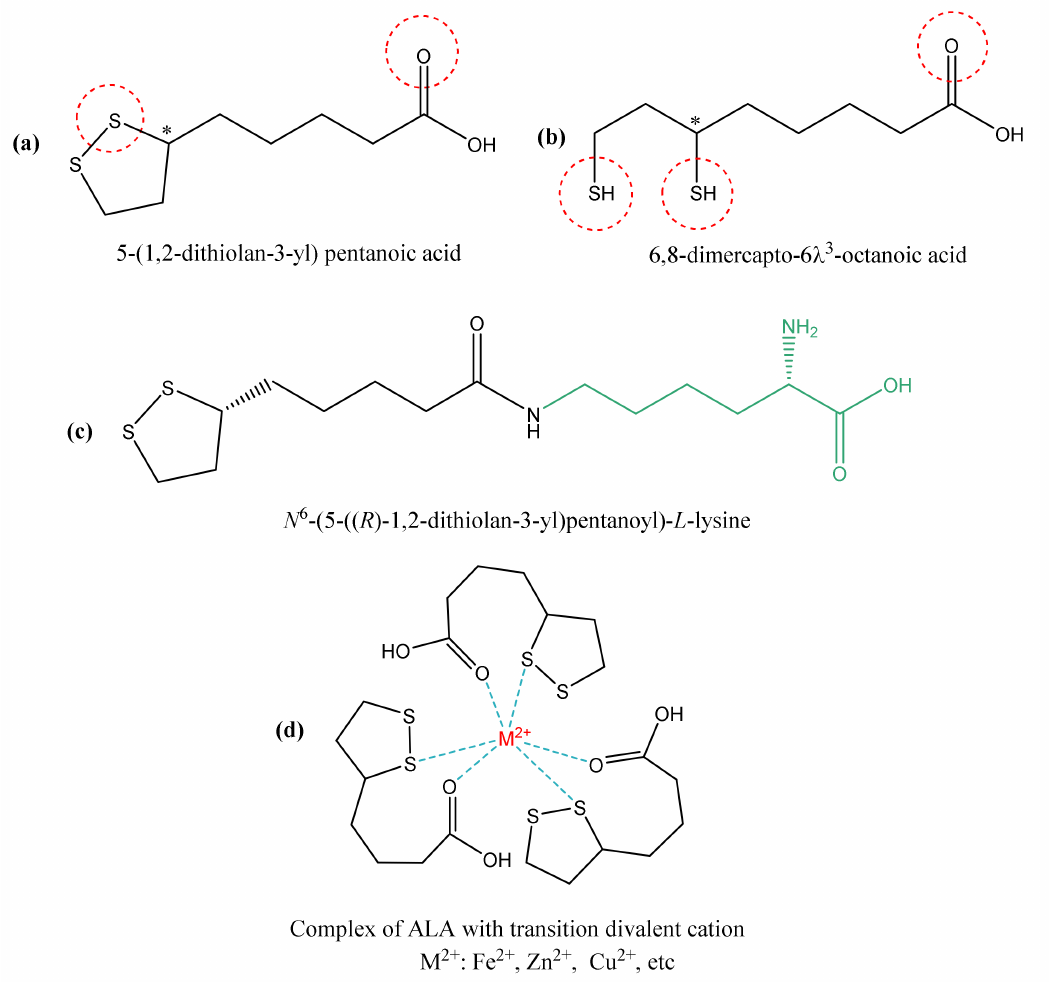
Figure 3. Chemical structures of ( a ) alpha-lipoic acid (ALA), ( b ) dihydrolipoic acid (DHLA), ( c ) lipoyllysine and ( d ) the complex of ALA with transition metals; cations; * asymmetric